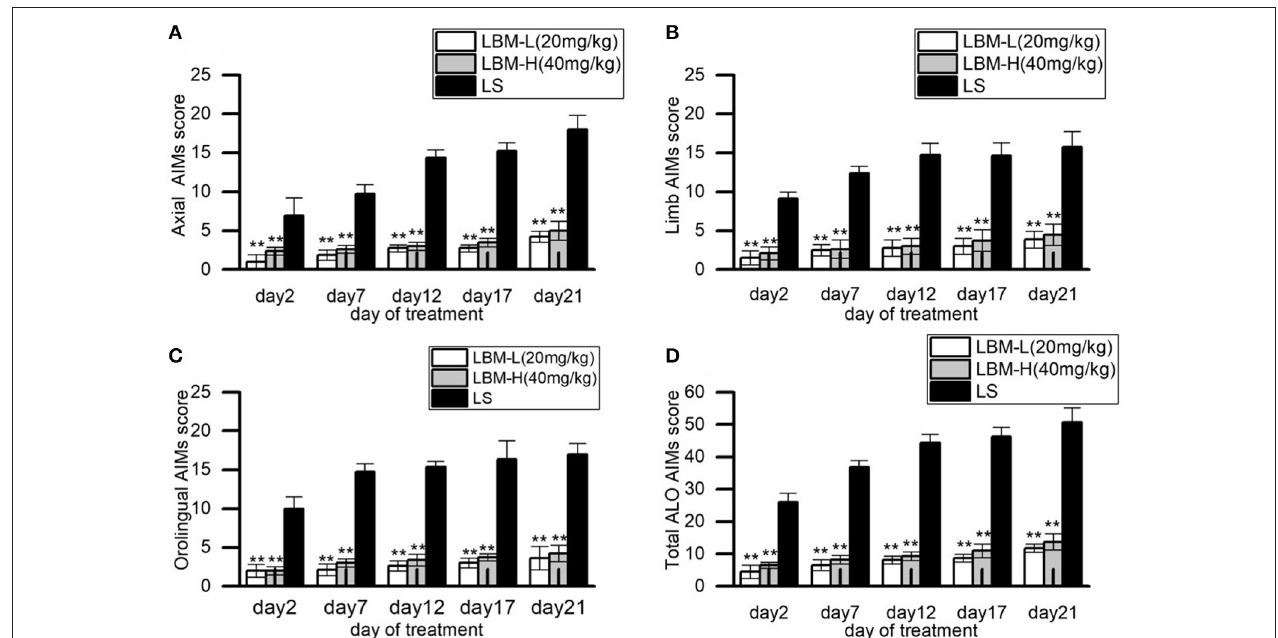
FIGURE 1 | Behavioral characteristics of the 6-OHDA-lesioned rats during 21 days of treatment with LBM-L (20 mg/kg), LBM-H (40 mg/kg), and L-dopa plus benserazide standard (LS). (A–D) Measures of Axial (A) , Limb (B) , Orolingual (C) , and the total ALO AIMs (D) in the rats treated with LBM-L, LBM-H, or LS group on each assessment during 21 days of treatment. During the period, intermittent administration of L-dopa induced a robust increase of the total ALO AIMs assessment and each of the sub items in 6-OHDA-lesioned rat models of PD, with apparent dyskinetic movements. In contrast, this phenomenon was not observed